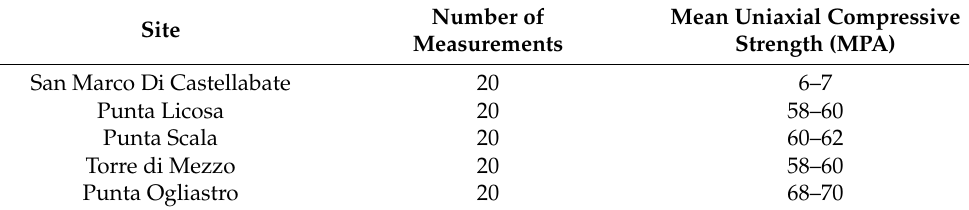
Table 2. Obtained UCS values along the Licosa promontory.